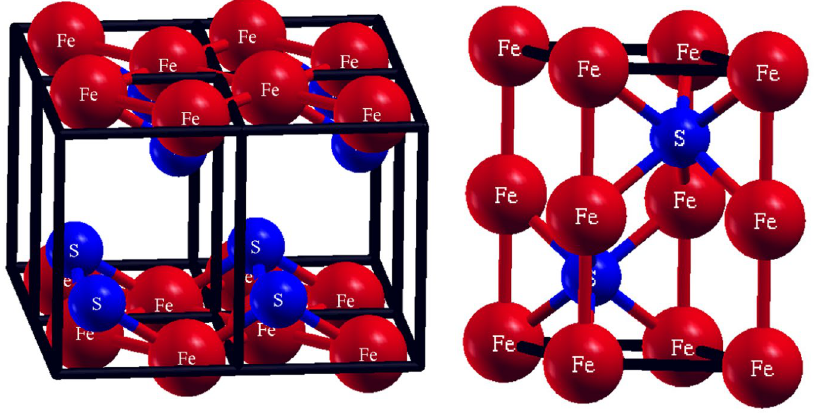
Figure 1. The two structures studied in this work. Left: the tetragonal structure; right, the hexagonal NiAs- structure. Pictures depict actual FeS structures.